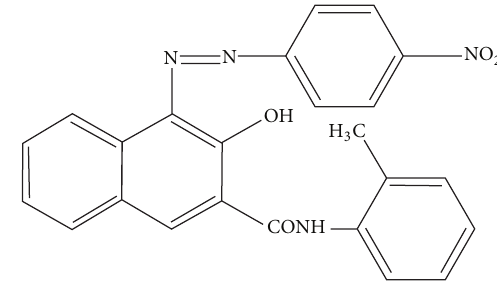
Figure 1: Structure of Naphthol AS-D pigment.